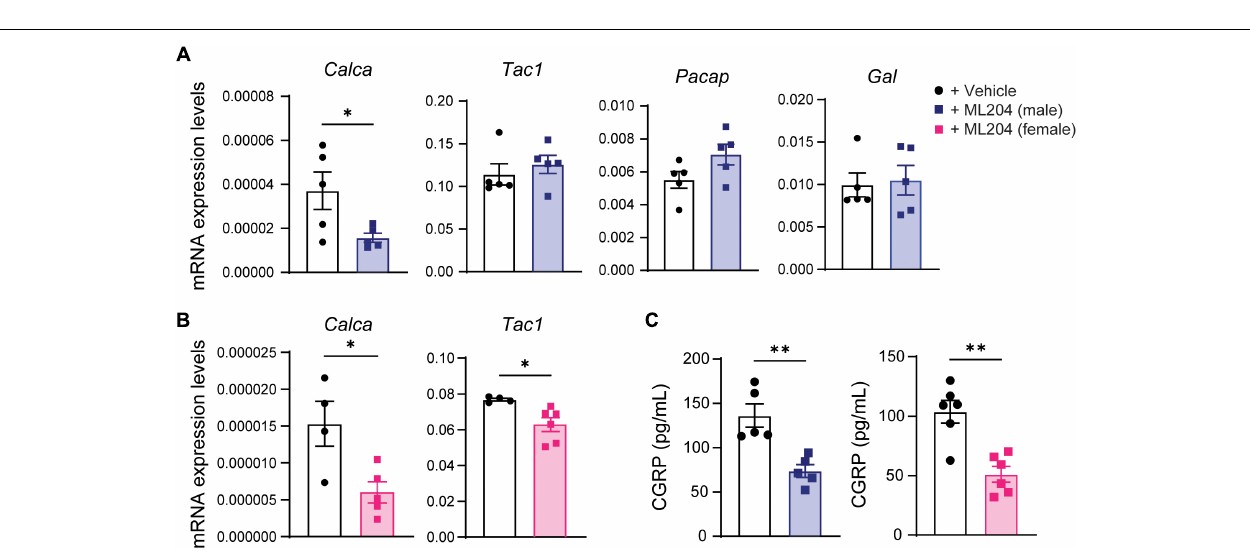
FIGURE 3 | TRPC4 inhibitor ML204 alleviates NTG-induced episodic and chronic pain in male and female mice. (A) Illustration of the mouse models used for acute (episodic) and chronic migraine, including timelines for treatment and behavioral tests. TRPC4 inhibitor ML204 prevents both acute and chronic mechanical hypersensitivity in male (B) and female (C) mice, which was assessed using a series of von Frey filaments applied to the plantar surface of the hind paw. ∗ p < 0.05, ∗∗ p < 0.01, ∗∗∗ p < 0.001, vs. vehicle. Two-way ANOVA followed by Bonferroni’s post hoc test, n = 5–6 mice/sex/group.